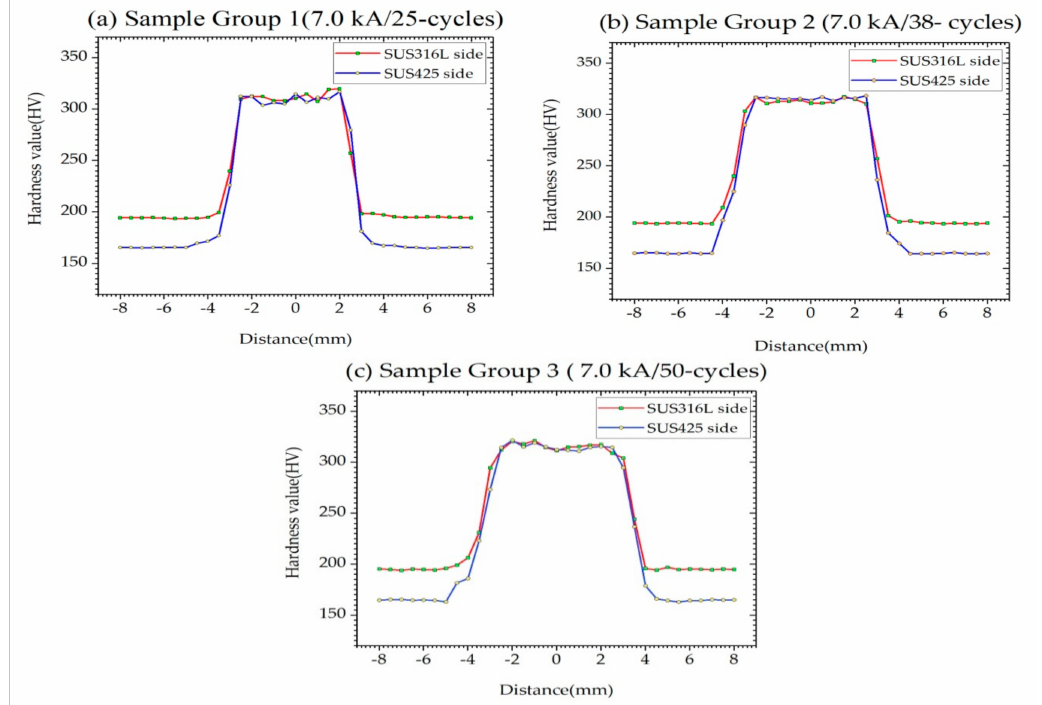
Figure 8. Micro hardness profiles of welded specimens given a 7.0 kA weld current: ( a ) 25; ( b ) 38; ( c ) 50-cycle welding